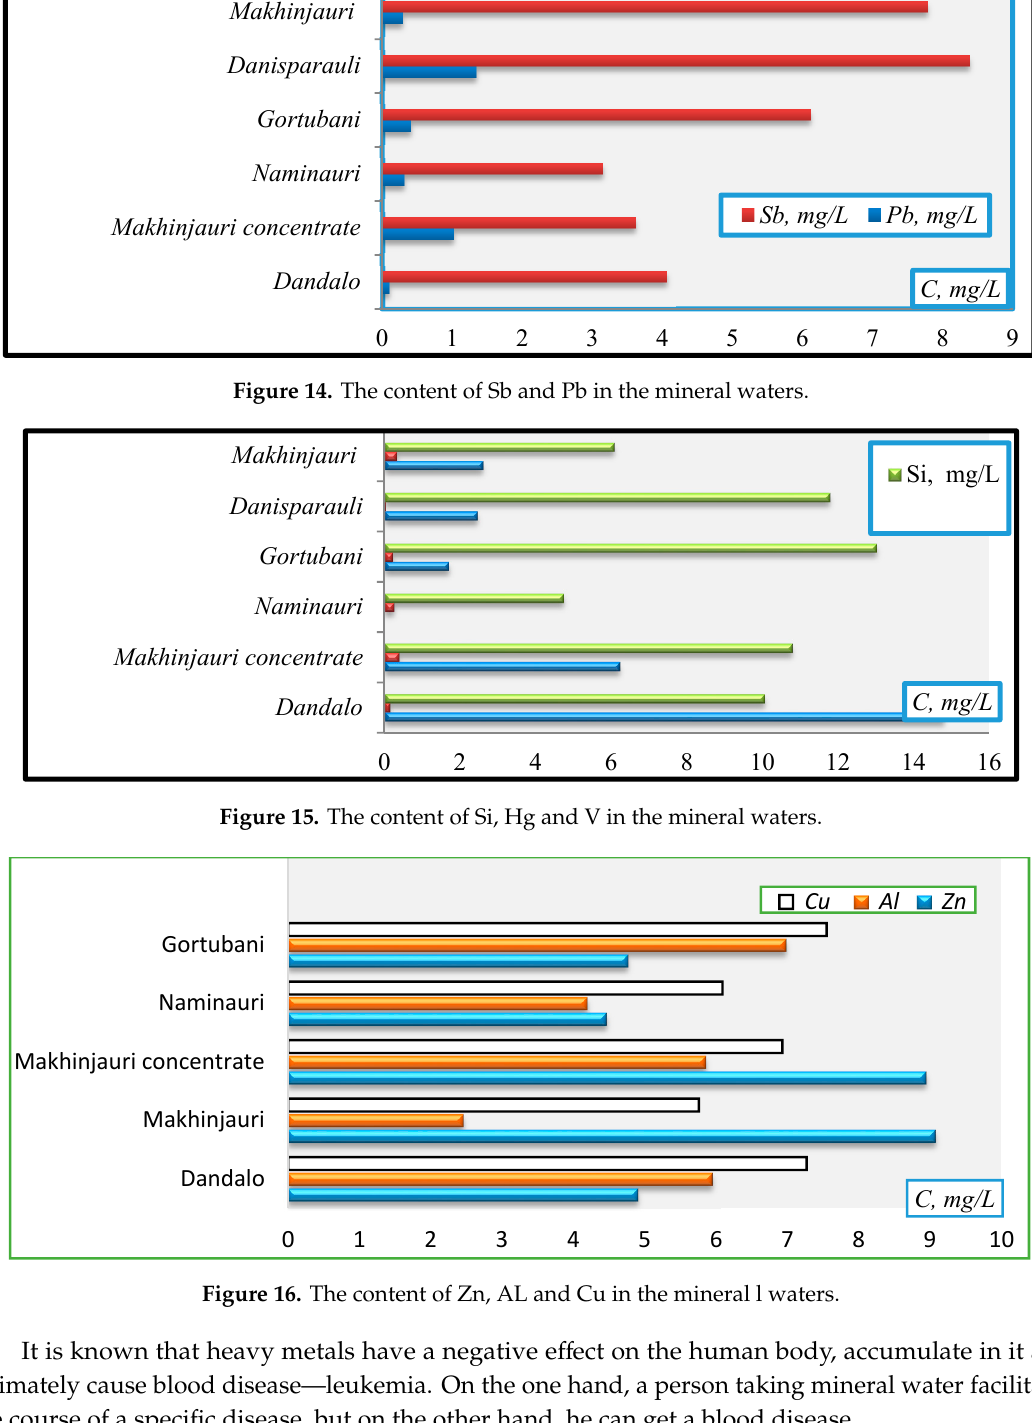
Figure 16. The content of Zn, AL and Cu in the mineral l waters.